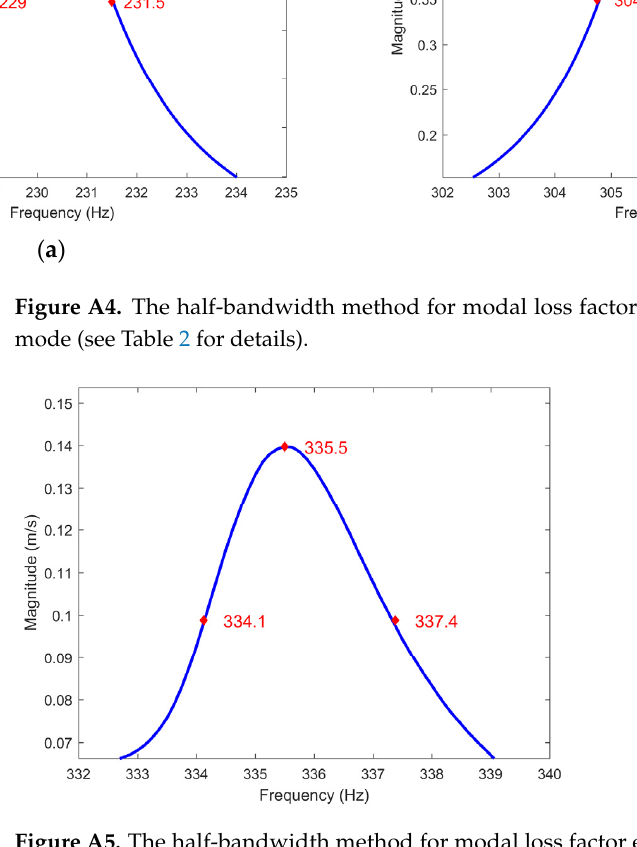
Figure A5. The half-bandwidth method for modal loss factor extraction for the seventh mode (see Table 2 for details).